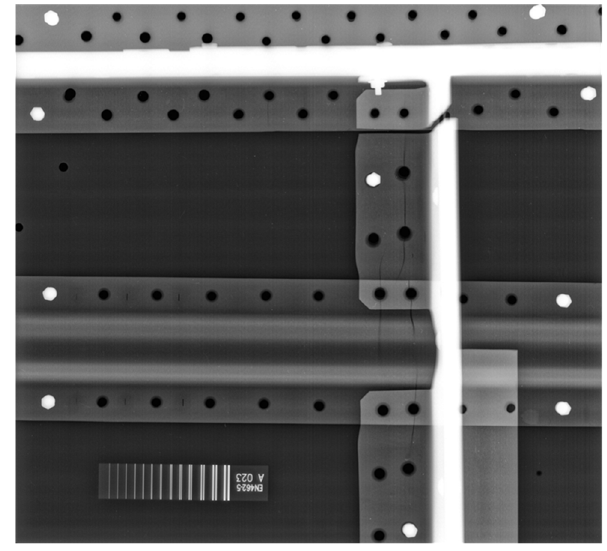
Figure 11. X-ray image of the airplane sample used in the initial experiments.